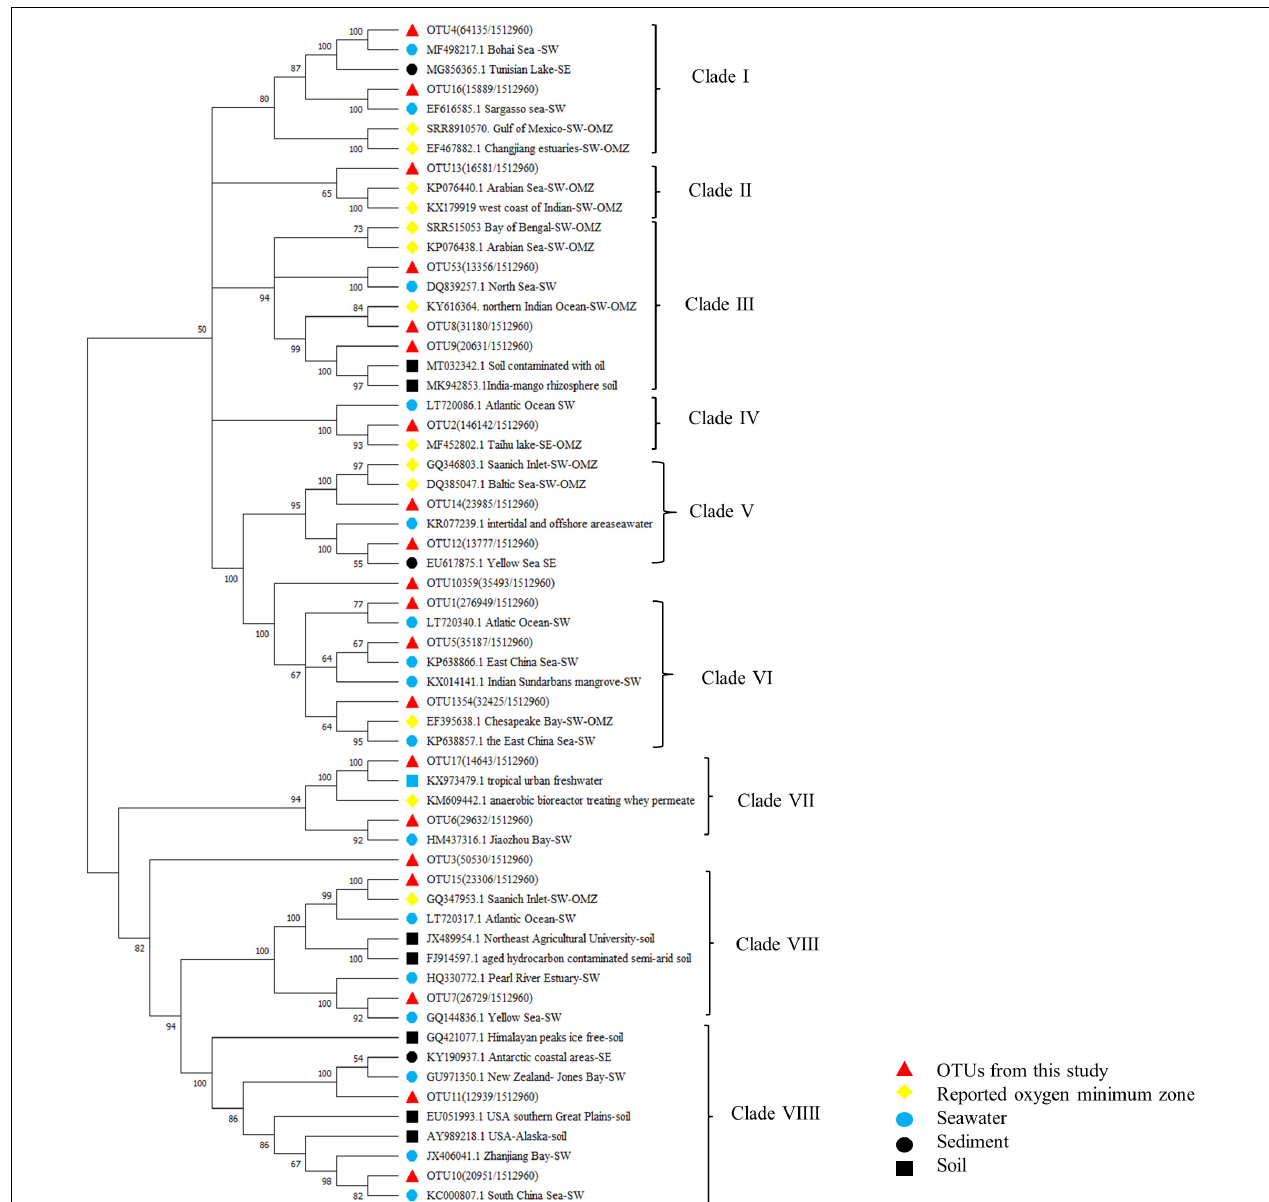
FIGURE 9 | Neighbor-joining phylogenetic tree of the dominant (Top 20 OTUs) OTUs and the reference sequences from typical OMZs. Bootstrap values were 1000